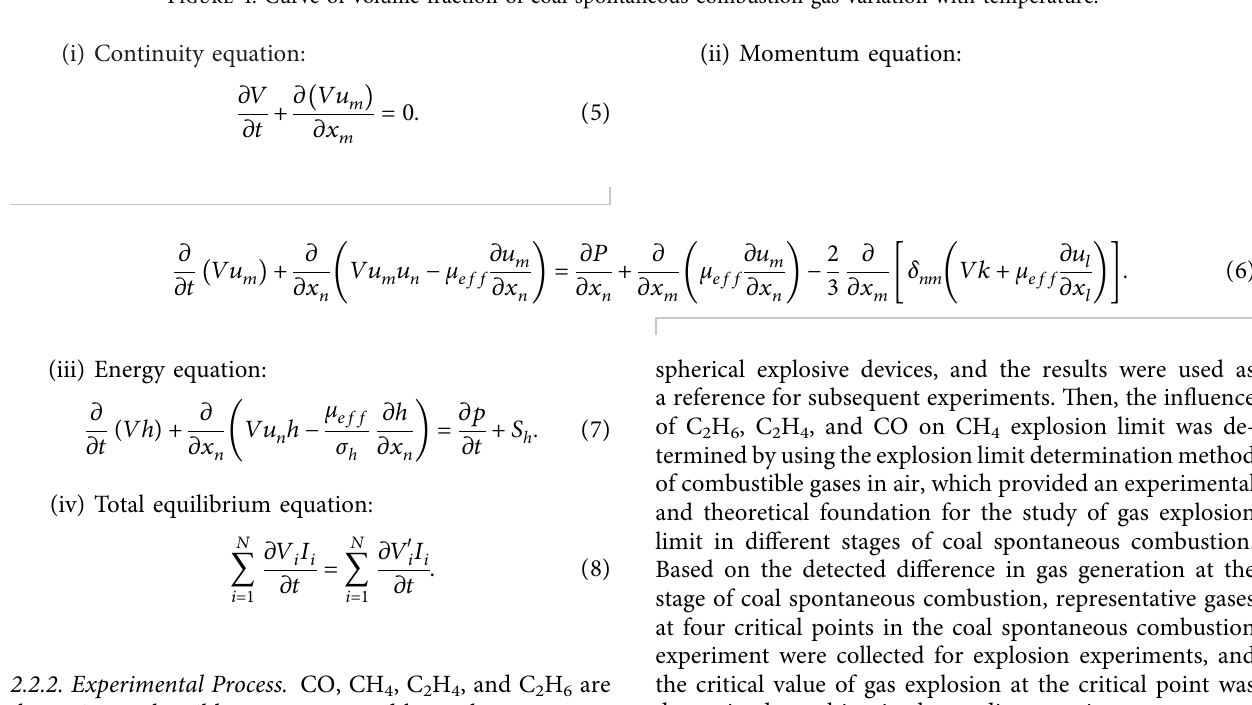
Figure 4: Curve of volume fraction of coal spontaneous combustion gas variation with